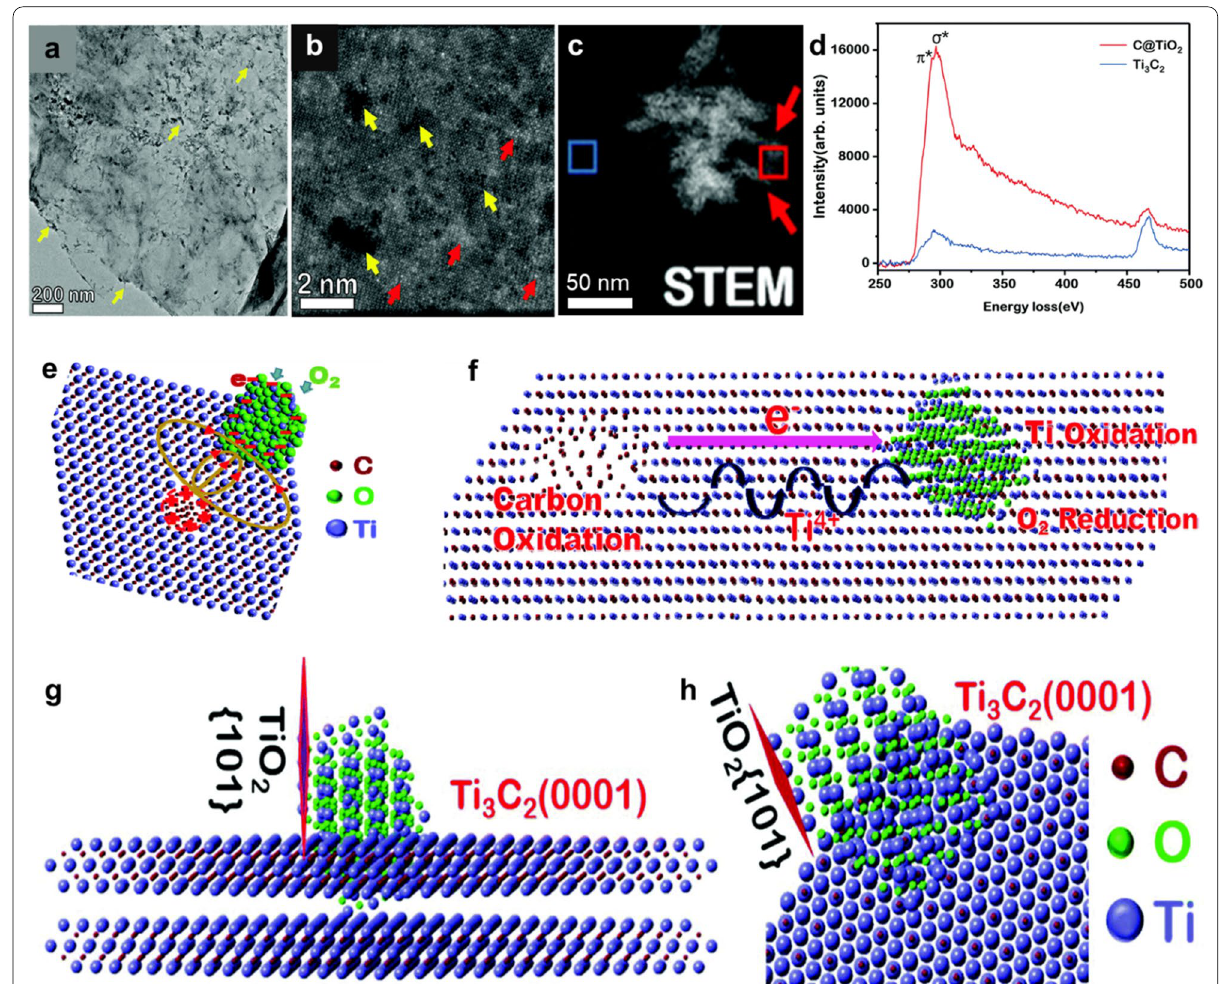
Fig. 3 a Bright-field TEM image of Ti 3 C 2 MXene flakes showing the formation of TiO 2 nanoparticles on edges as well as on the basal plane. b A Z-contrast STEM image showing the Ti-vacancies (dark contrast marked by yellow arrowheads) and Ti–rich areas (bright contrast marked by red arrowheads). c HAADF-STEM image and elemental maps of C, O, and Ti collected by EELS, showing the coexistence of TiO 2 nanoparticles and amorphous carbon aggregation. d A comparison of EELS spectra, collected from the carbon aggregation marked by the red box in c and the Ti 3 C 2 substrate marked by the blue box. e Schematic of the internal electric field, with the positive side formed around a hole with many Ti-vacancies and the negative side with the accumulation of electrons on the convex particle. f Illustration of Ti 3 C 2 oxidation with carbon being oxidized on the positive side of the internal electric field and Ti-ions being oxidized on the negative side. g , h Illustration of the TiO 2 cluster on Ti 3 C 2 with the TiO 2 -(101) plane perpendicular to the MXene basal plane (0001). a – h are reproduced with permissions from ref. [52]. Copyright (2019), Royal Society of